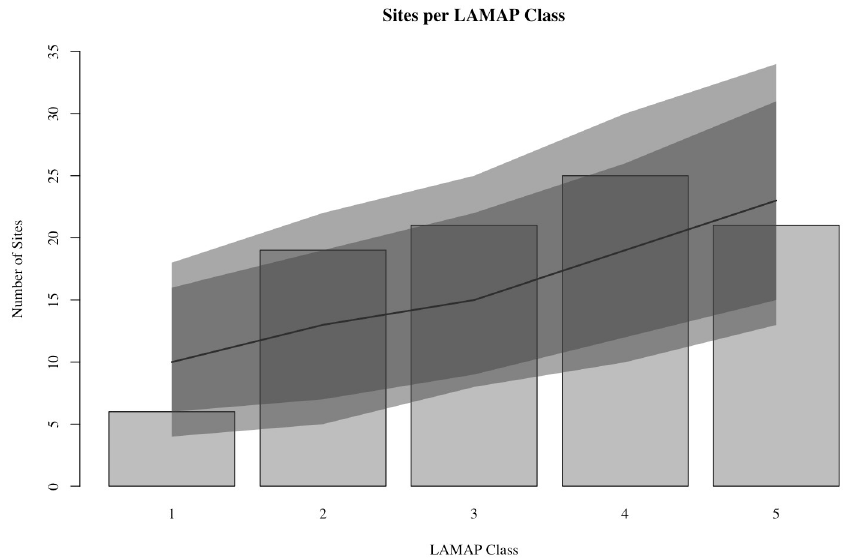
Fig 3. Relationship between LAMAP class and the number of sites found on land of each class, randomly selected sites. The grey vertical bars indicate the number of sites located in cells with the given potential estimate. The solid black trend-lines indicate the expected number of sites for a given LAMAP class according to the Poisson regression model. The 95% and 99% posterior predictive intervals for the regression models are indicated by the darker and lighter grey shaded ribbons, respectively.